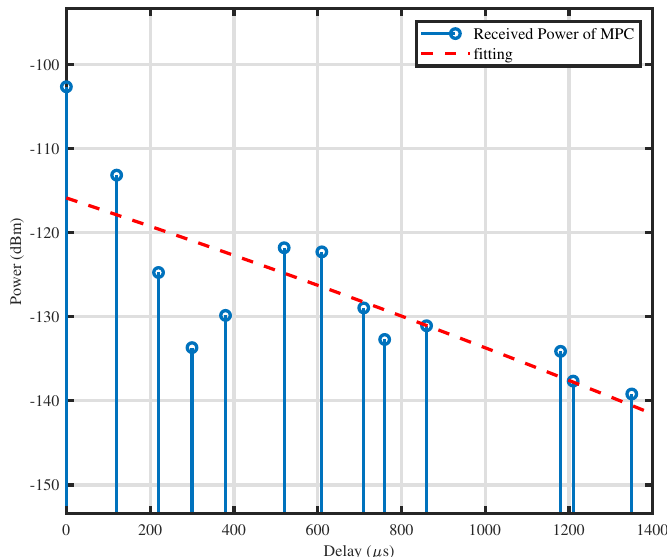
Figure 12. Measured PDP and fitted (red dashed) line showing the linear dependence between the power versus